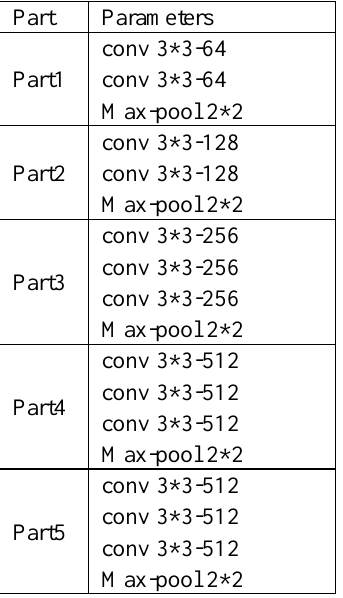
Table 1 Parameters of 4 part in VGG-16 feature extractor A convolutional layer get a feature map by computing the dot product between the receptive field and kernel. In general, an activation function is added behind each convolutional layer, such as the Sigmoid function, Rectified Linear Unit (ReLU), Tanh et al. This part uses the ReLU as the activation function.